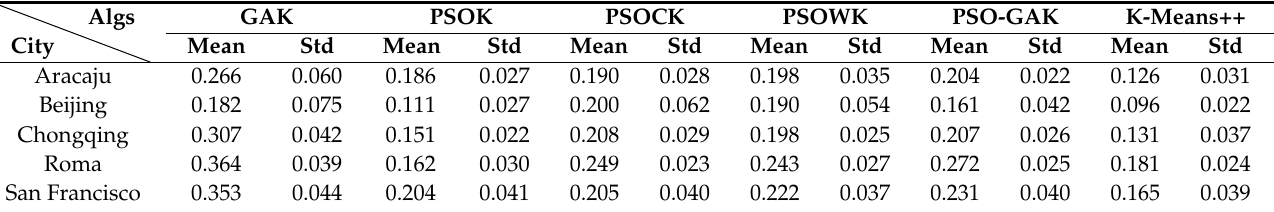
Table 9. ACI index for novel FPSO-GAK vs. other